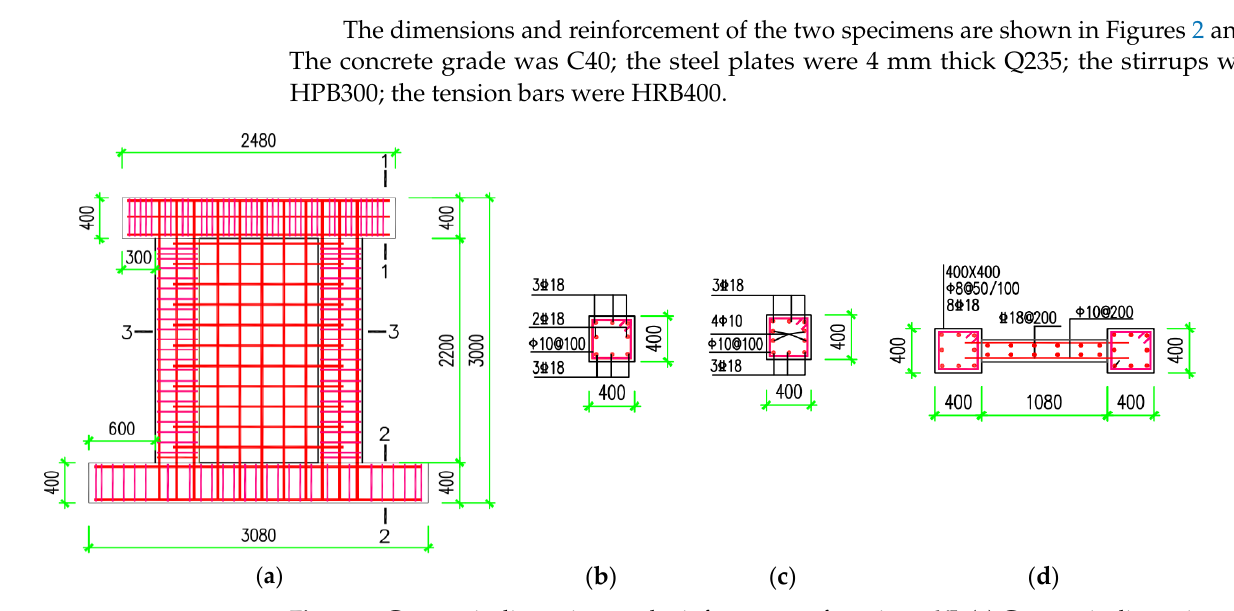
Figure 2. Geometric dimensions and reinforcement of specimen XJ. ( a ) Geometric dimensions and reinforcement of specimen XJ; ( b ) 1 – 1; ( c ) 2 – 2; ( d ) 3 – 3.